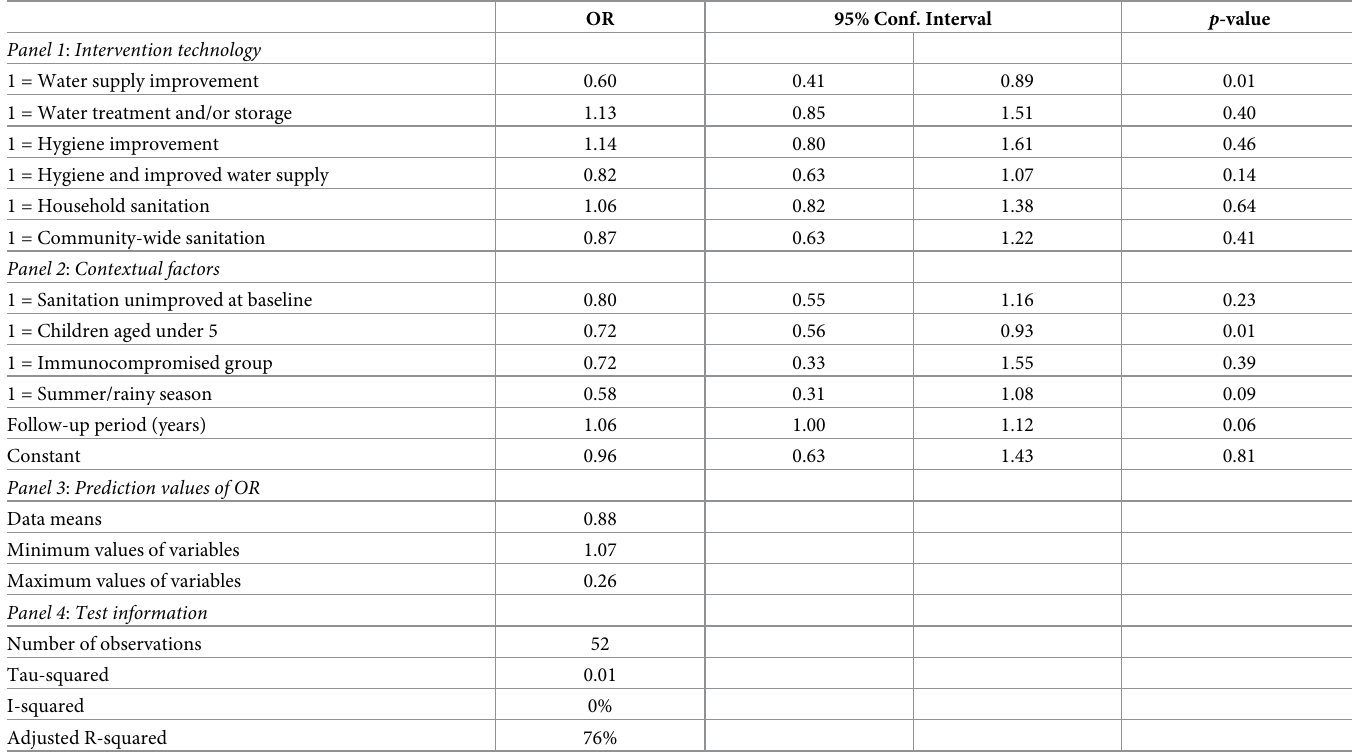
Table 1. Meta-regression analysis of all-cause mortality with prediction